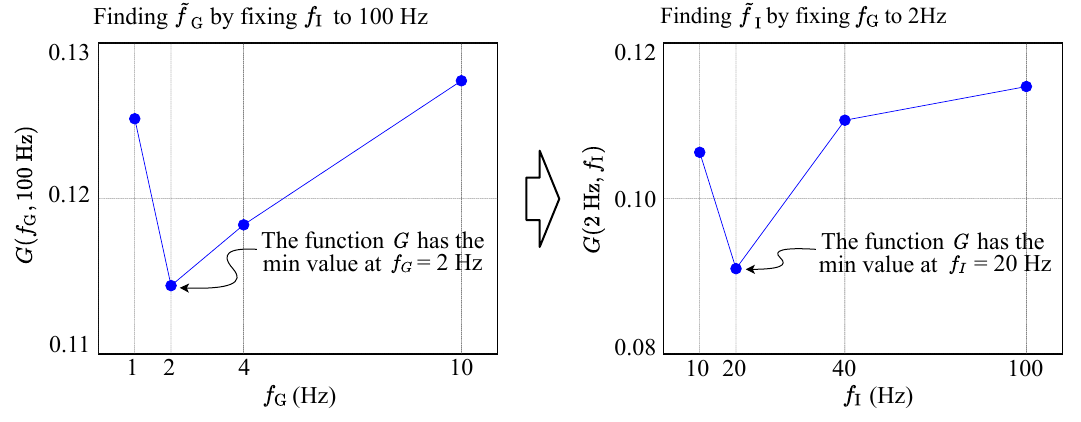
Figure 10. Evaluating the objective function using Algorithm 1 to find the near-optimal sensing-rate configuration of the turning_slow